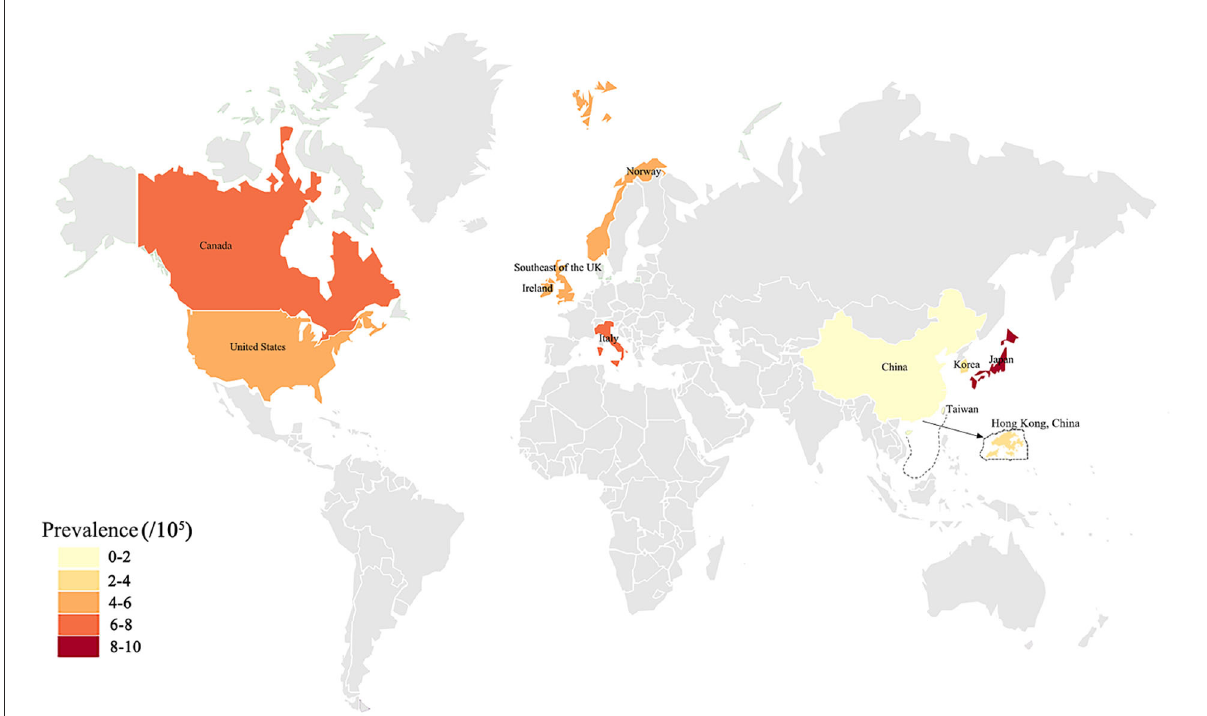
FIGURE4 The previously reported ALS prevalence in the global different countries or districts was exhibited on the world map. The deep and shallow color indicated the high and low of ALS prevalence. Deeper color indicated higher ALS